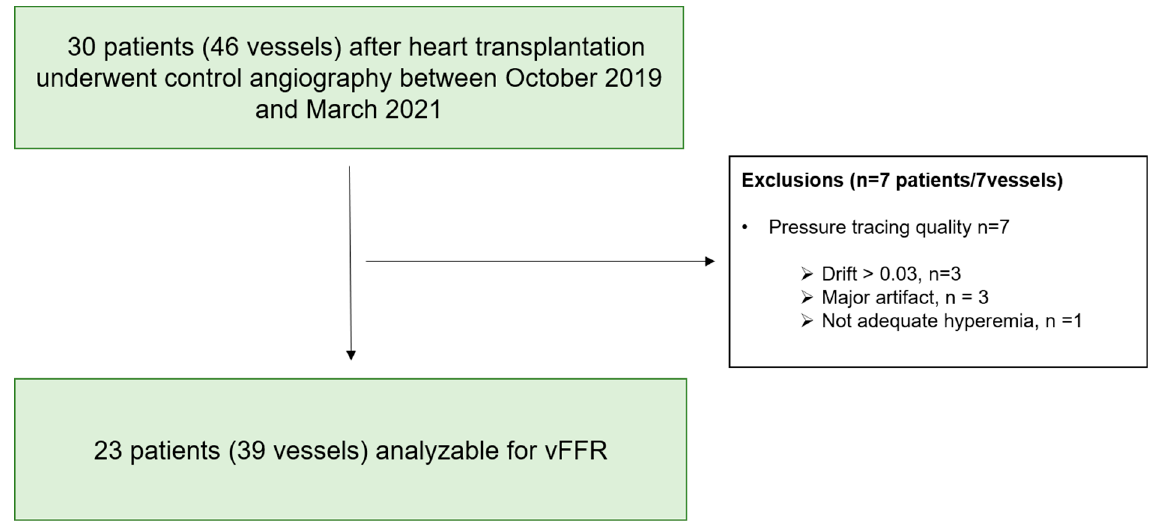
Figure 1. Patient selection flow chart. vFFR—angiography derived fractional flow reserve. Table 1. Patient demographic and clinical characteristics. Table 2. Patient procedural